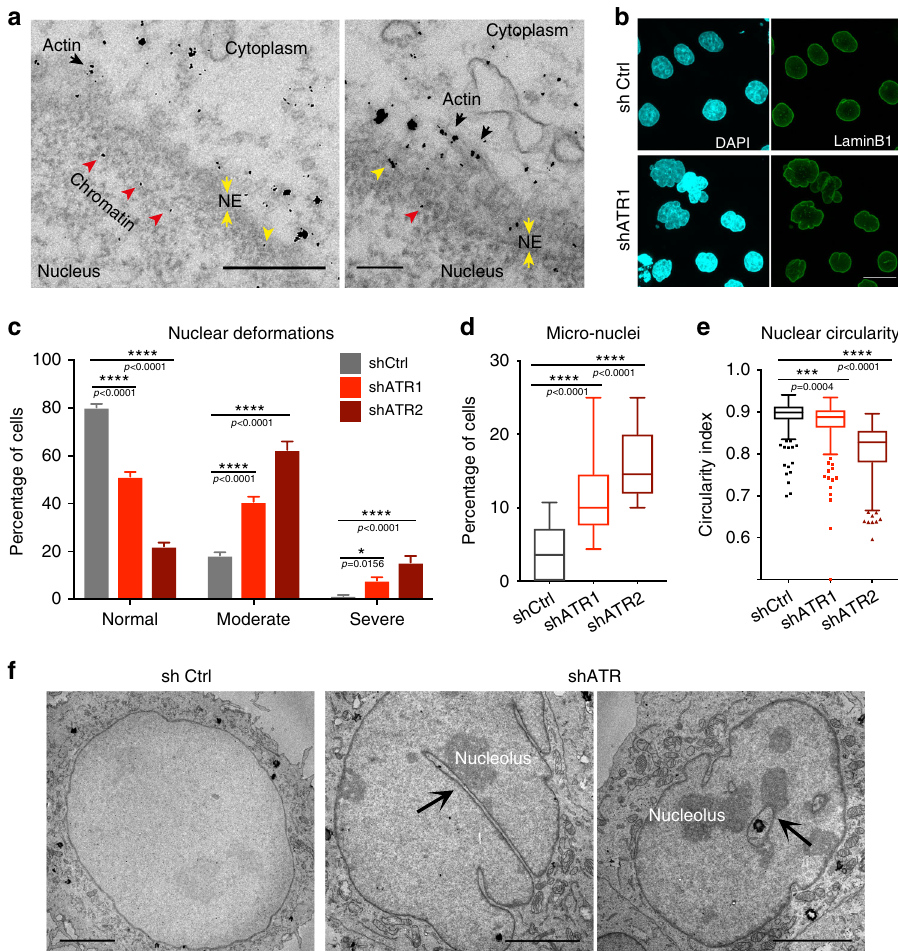
Fig. 1 ATR interacts with membranes and preserves nuclear morphology. a Images from routine 60 nm EM section with enrichment of nano-gold-labeled ATR in the perinuclear region. Colored arrowheads indicate actin-associated (black), chromatin-associated (red), and membrane-associated ATR (yellow), respectively (scale bar 500 η m for the right and 200 η m for the left panel). b Defective nuclear morphology of ATR-depleted HeLa cells visualized with immuno fl uorescence of Lamin B1 (NE) and DAPI (DNA) (scale bar = 50 μ m). c Quanti fi cation of nuclear deformations by manual sorting based on their degree of deformation: Normal, mildly deformed and severely deformed ( n = 515, 525, 229 cells for shCtrl, shATR1, and ShATR2, respectively). Quanti fi cations of d micronuclei ( n = 515, 525, and 229 cells for shCtrl, shATR1, and ShATR2, respectively) and e nuclear circularity index ( n = 288, 253, and 215 cells for shCtrl, shATR1, and ShATR2, respectively; N = 3 independent experiments). f EM images of the nucleus from control and ATR-depleted HeLa cells. Arrowheads indicate invaginations with nucleoli attachment (scale bar 5 μ m). Bar graphs presented as mean ± SEM and box plot whiskers and outliers plotted with Tukey ’ s method. p -values calculated using two-way ANOVA test for c or for d . e Ordinary one-way ANOVA test with Dunnett ’ s multiple comparisons test (**** P < 0.0001, *** P < 0.001, ** P < 0.01, * P < 0.05; NS, not signi fi cant). Source Data fi le contains source data and all additional details of statistical